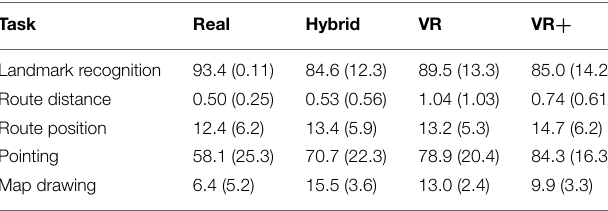
TABLE 2 | Mean performance for each task for each group of